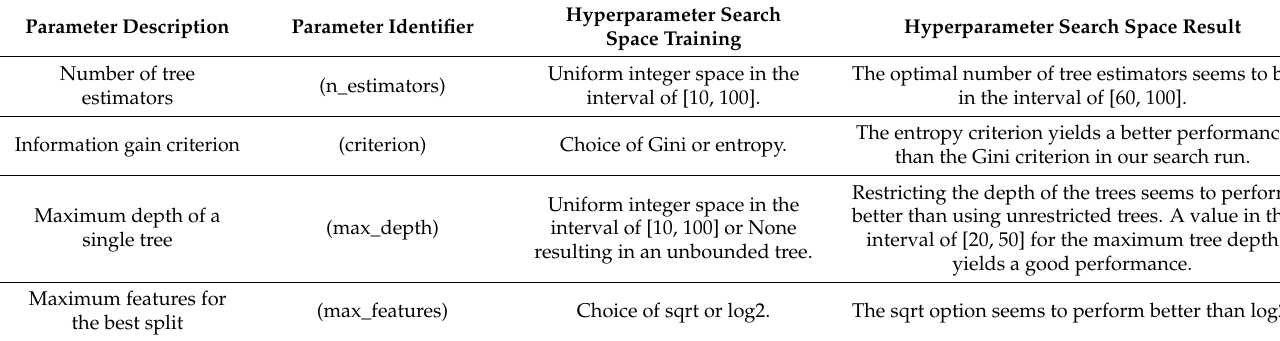
Table 5. Hyperparameter search space for random